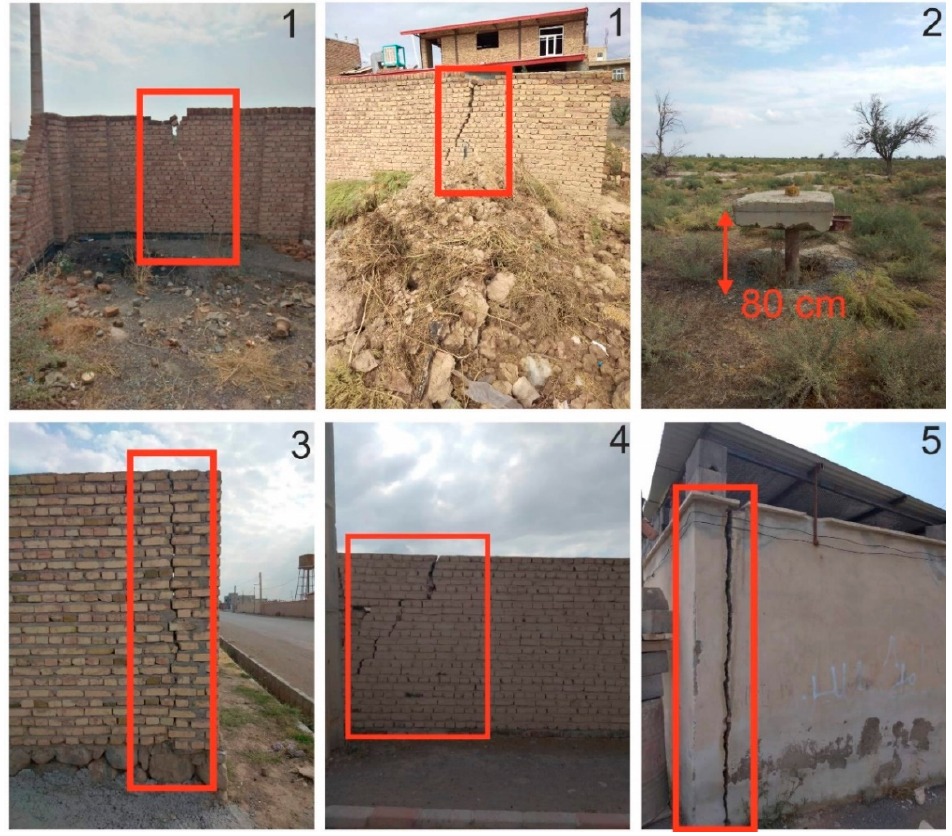
Figure 9. Subsidence evidence at different locations in Shabestar basin. Locations of images are shown in Figures 1c and 7a.